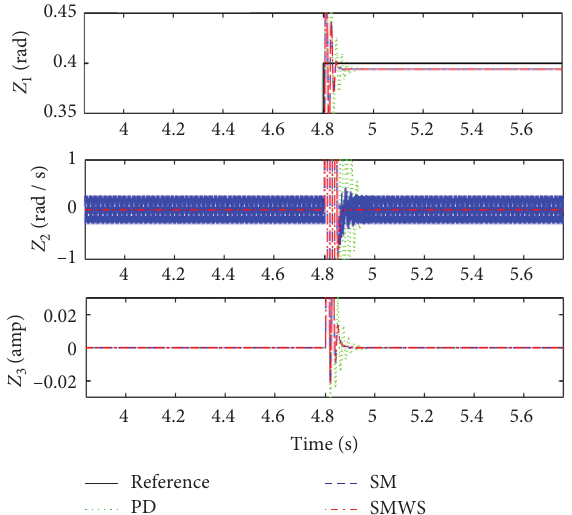
Figure 7: A zoom in the states of the first electricity generator. Figure 9: Fictitious input of the second electricity Table 5: Comparisons for the first electricity generator. RMSE for 􏽥 z RMSE for v